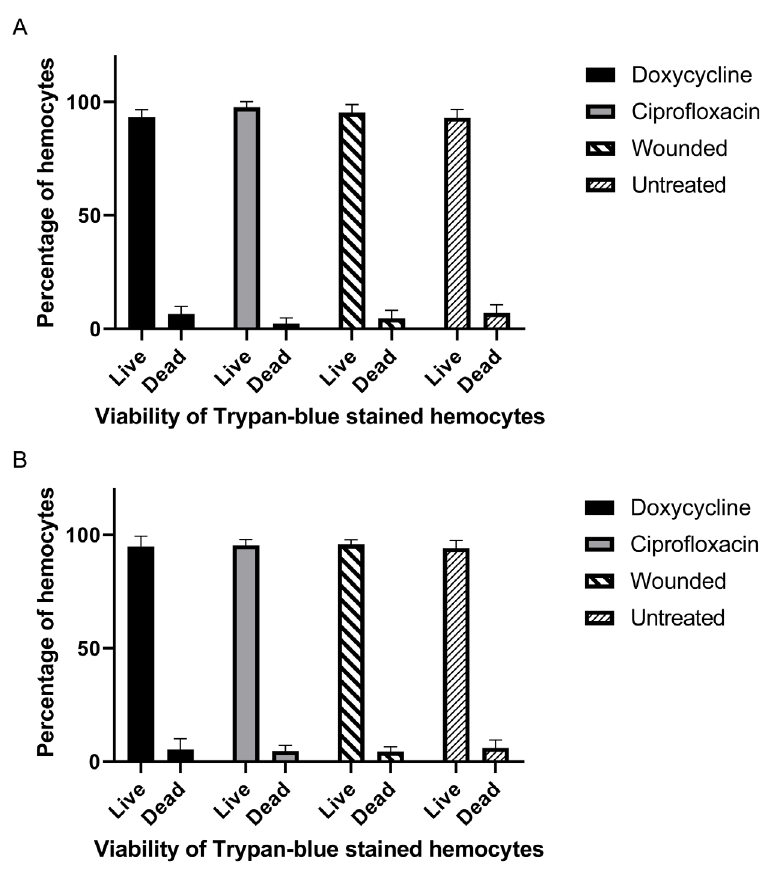
Figure 4. Viability of hemocytes incubated at 28ºC at T0 ( A ) or T7 ( B ). Average across three replicate wells per treatment, derived from the pooled hemolymph from 10 larvae, and seeded at 2 x 10 5 cells/ml. Hemocytes dissociated with trypsin and stained with trypan blue. Error bars = SD. Mean percentage (and SD) of hemocytes live at T0: doxycycline treated, 93% (±3.2%); ciprofloxacin treated, 98% (±2.5%); wounded, 96% (±3.5%); untreated, 93% (±3.6%). Mean percentage (and SD) of hemocytes live at T7: doxycycline treated, 95% (±4.7%); ciprofloxacin treated, 95% (±2.5%); wounded, 96% (±2.1%); wounded, 94% (±3.5%).